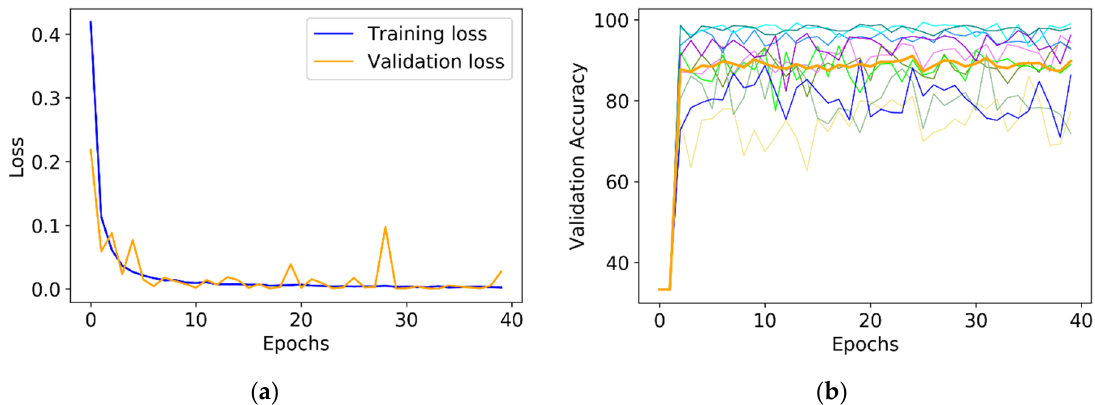
Figure 14. Loss and validation accuracy during convolutional neural network training and validation, averaged for all cross-validation folds: ( a ) training and validation loss by epoch; ( b ) validation accuracy value by epoch. The thick orange line is the average over all folds.